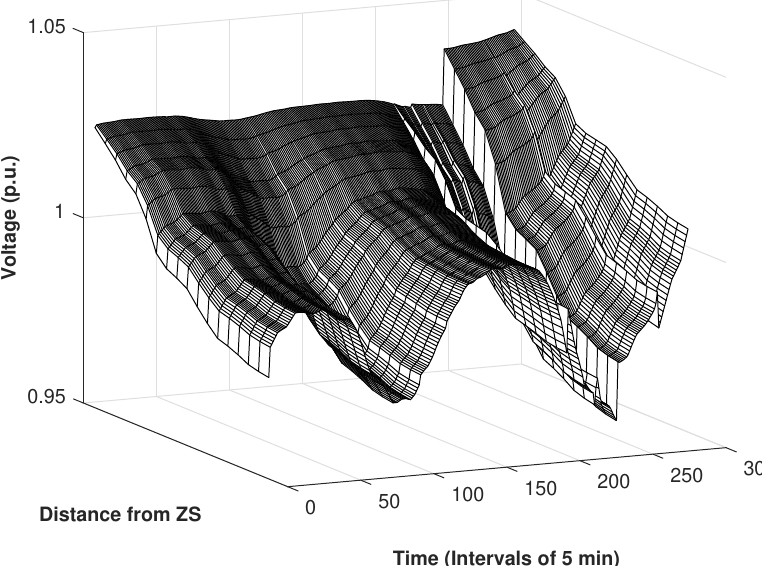
Figure 10. Voltage at Feeder 1 using the proposed volt/var control strategy. Using the proposed volt/var control strategy, the number of tap change operation performed by the OLTC at the ZS is reduced to one. The difference is due to the lack of stepping down operation once the load demand decreases after the 270th